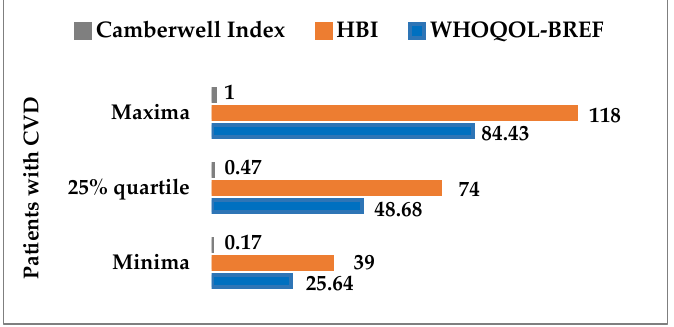
Figure 2. Better effectiveness of care for the group of patients under home care by a nurse—above the 25% quantile: WHOQOL-BREF quality of life, health behavior inventory, Camberwell index. Respondents were divided into two groups: LEHC and HEHC. The patient was included in the HEHC group if all scores (Camberwell, WHOQOL-BREF, and HBI) were above their 25% quantiles. The other patients were included in the LEHC group. This criterion allowed the formation of two groups that were comparable in size. Based on